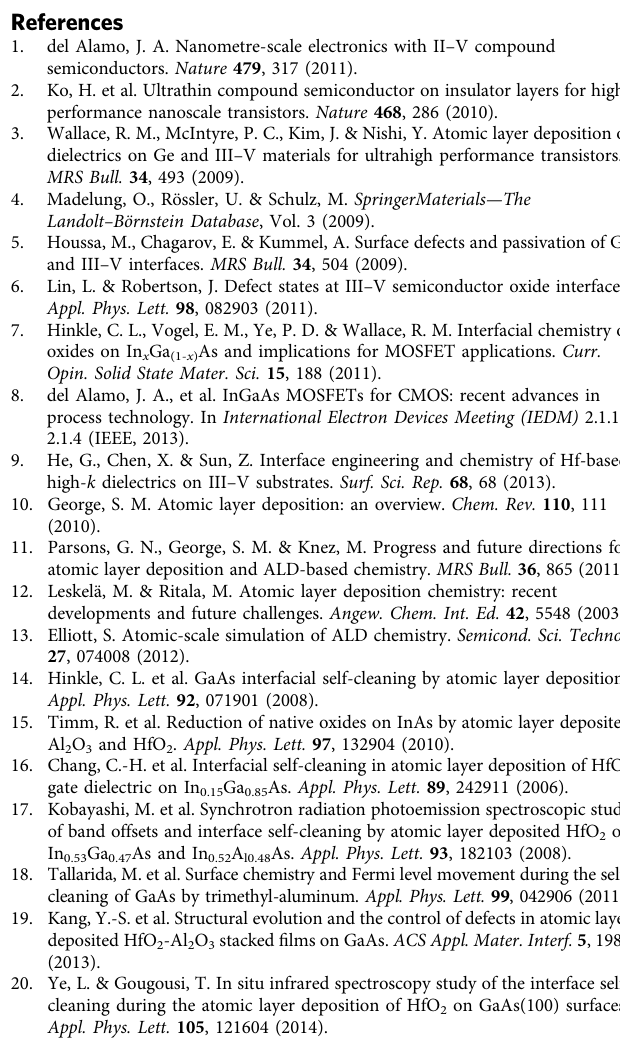
Table 1 were used consistently for all spectra, in agreement with earlier mea- surements 15,33 . Binding energies were calibrated using the values of 41eV for As